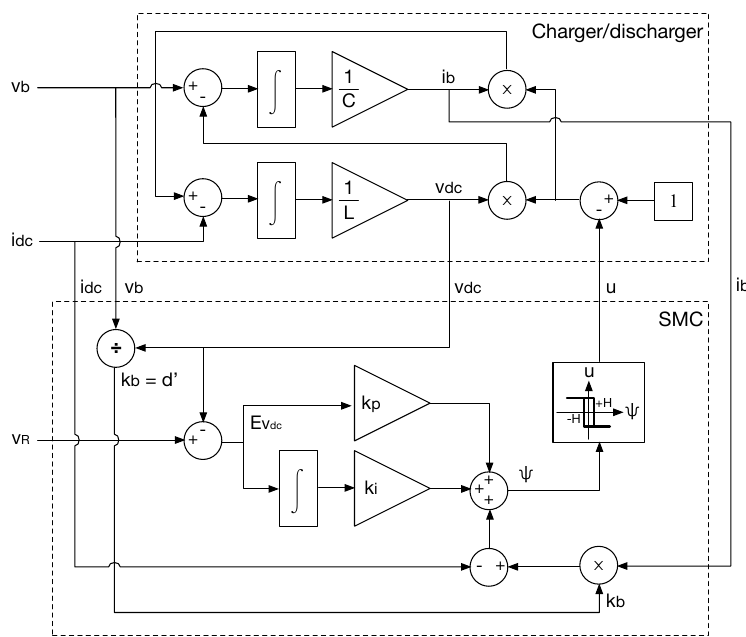
Figure 12. Block diagram of the charger/discharger and the sliding-mode controller